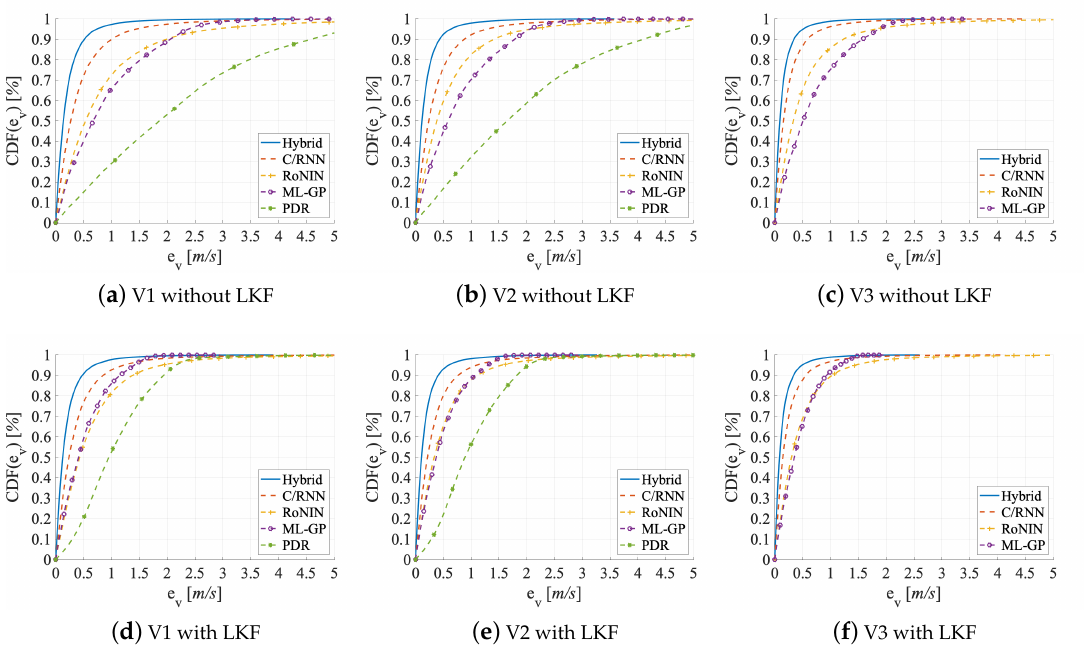
Figure 9. CDF on test sets V1–V3, both without and with linear Kalman filter (LKF).